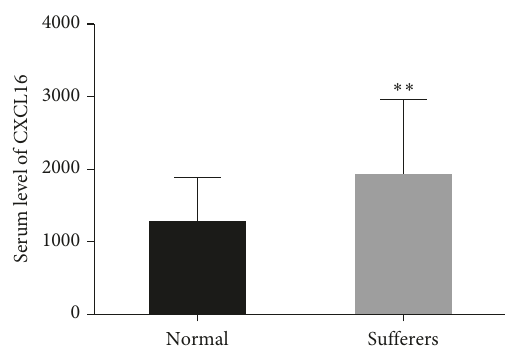
Figure 1: The serum level of CXCL16 was upregulated in PF sufferers ( ∗∗ p < 0 . 01 vs